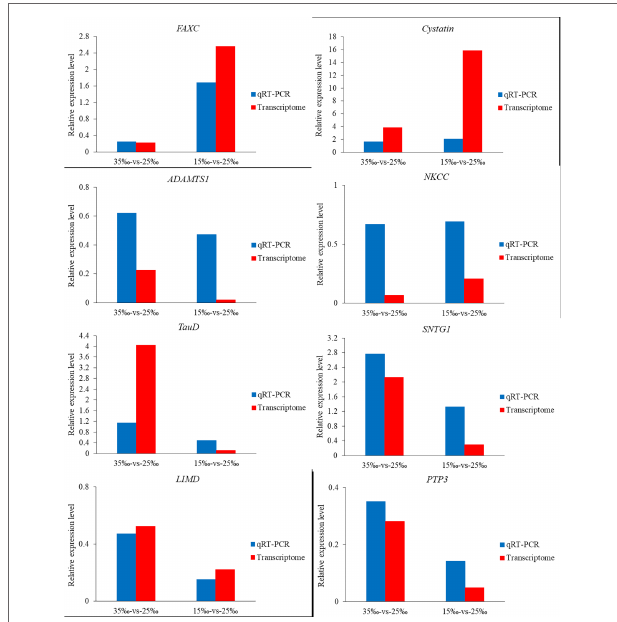
FIGURE 6 | Relative expression level of 8 salinity fluctuation-related genes based on transcriptomes data and qRT-PCR